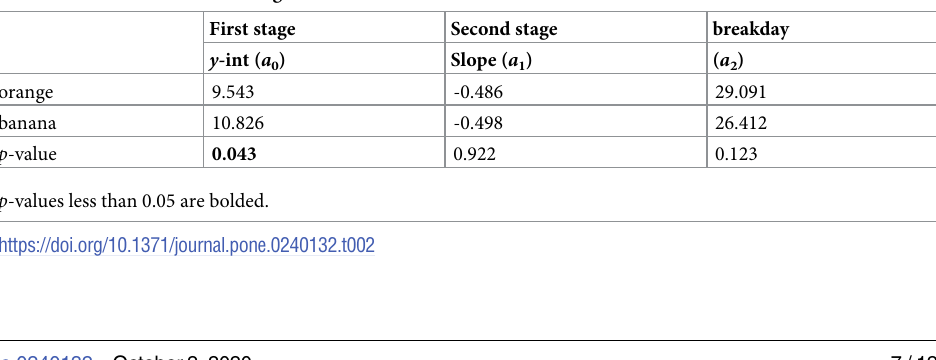
Table 2. Parameter estimates from the two-stage linear model fitted to p x m x data from the ACO populations treated with the banana and orange